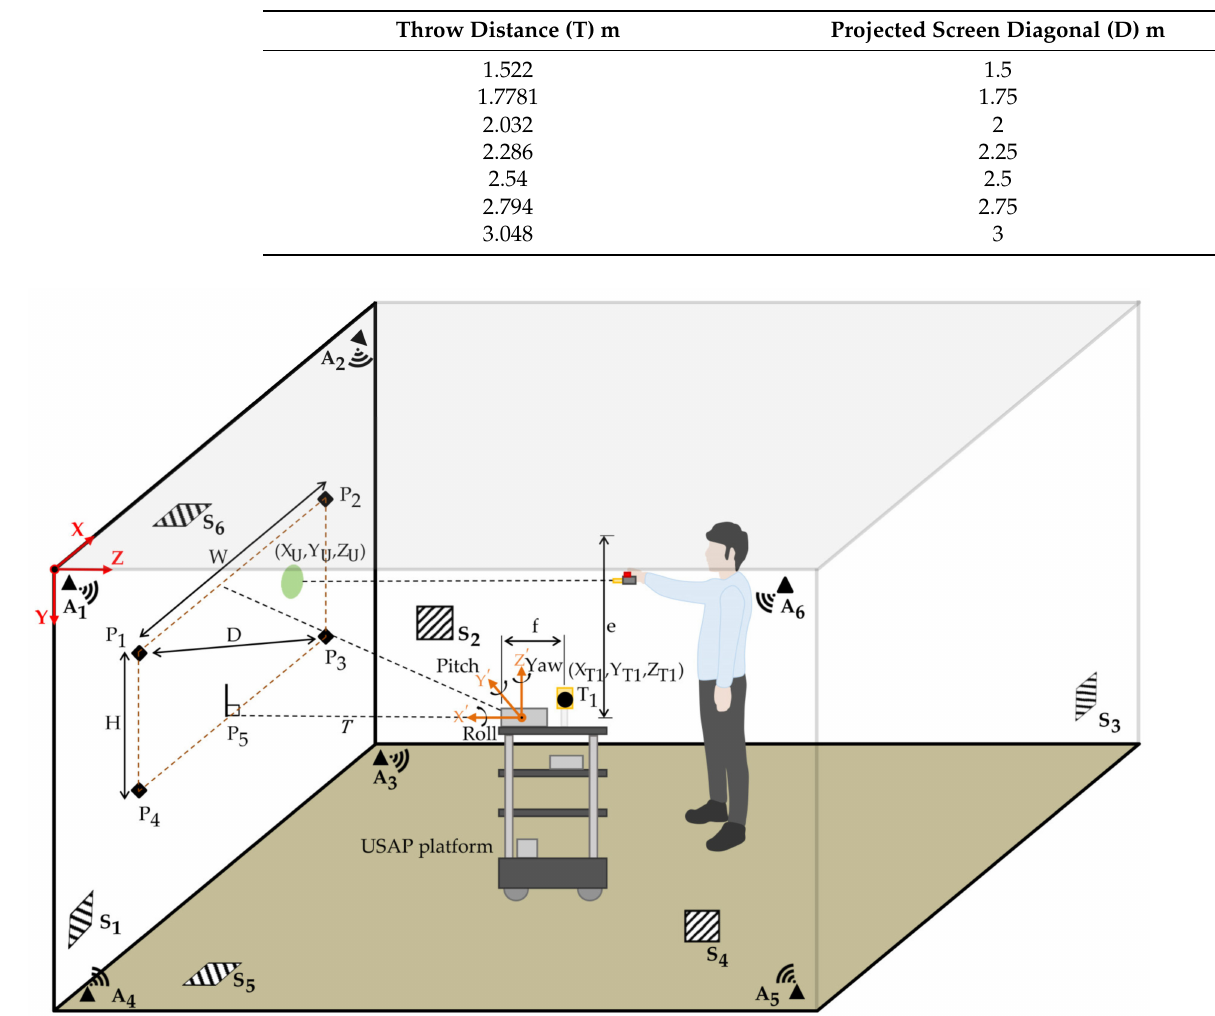
Table 2. Relation between throw distance (T) and diagonal distance for the projected screen (D).